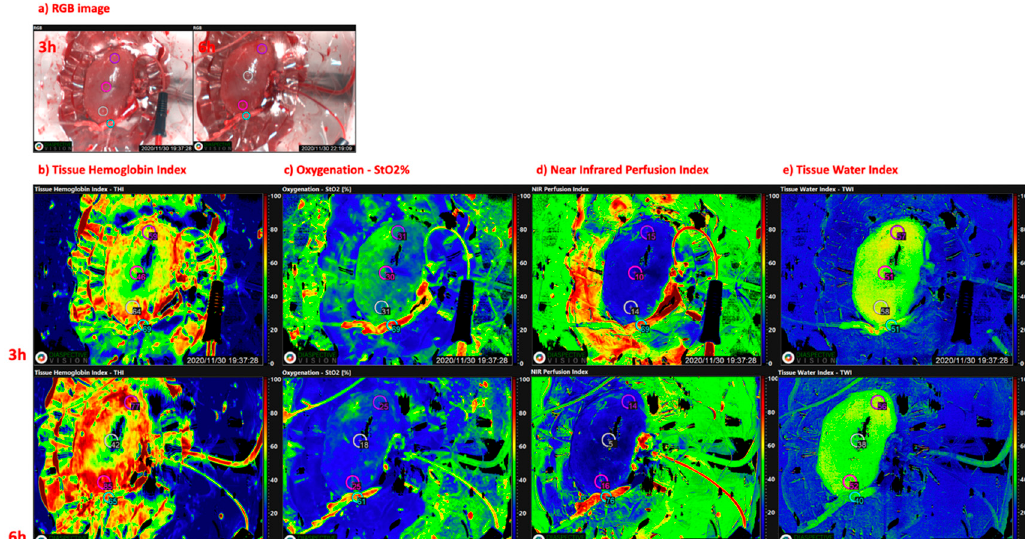
Figure 1. Hyperspectral imaging (HSI) applied on porcine kidneys after 3 h and 6 h NMP in an experimental setting; representative intraoperative ( a ) RBG image, corresponding HSI generated color coded, ( b ) tissue hemoglobin index (THI), ( c ) oxygen saturation index (StO2%), ( d ) near-infrared perfusion index (NIR), ( e ) tissue water index (TWI). Four standardized markers were placed on upper pole, corticomedullary boundary, lower pole, and ureter. Intraoperative images were acquired using the TIVITA ® Tissue HSI system (Diaspective Vision, Germany). For undisturbed image acquisition and data generation, the ambient light in the operating room had to be dimmed. The camera system incorporates a high number of spectrally differentiated channels, and acquires pictures with a high spectral resolution (5 nm) in the visible and near-infrared range (500–1000 nm). This scanner is mounted on a moving arm, which is brought to the organ. Using a 25 mm focal lens, a constant distance of 50 cm between the object and camera has to be retained during image acquisition. The HSI camera subsequently takes an RGB picture and in parallel computes a pseudo-color image, which represents physiologic parameters such as oxygen saturation, near-infrared perfusion, tissue hemoglobin, and tissue water of the recorded area. The maximum relative penetration depth of this HSI system is 6 mm. Quantitative StO2% measurements can either be performed at a depth of up to 1 mm for superficial microcirculation evaluation as well as at a depth of 4–6 mm, which corresponds to wavelengths recorded within the near-infrared spectrum. HSI can be applied almost “real time” and the acquisition for the hyperspectral image takes less than ten seconds. All images are stored, and further analysis of the hyperspectral data can be performed on the system with the TIVITA ® Suite software. HSI: hyperspectral imaging; NMP: normothermic machine perfusion; RGB: red-green-blue image; THI: tissue hemoglobin index; StO2%: oxygen saturation index; NIR: near infrared perfusion index; TWI: tissue water index.